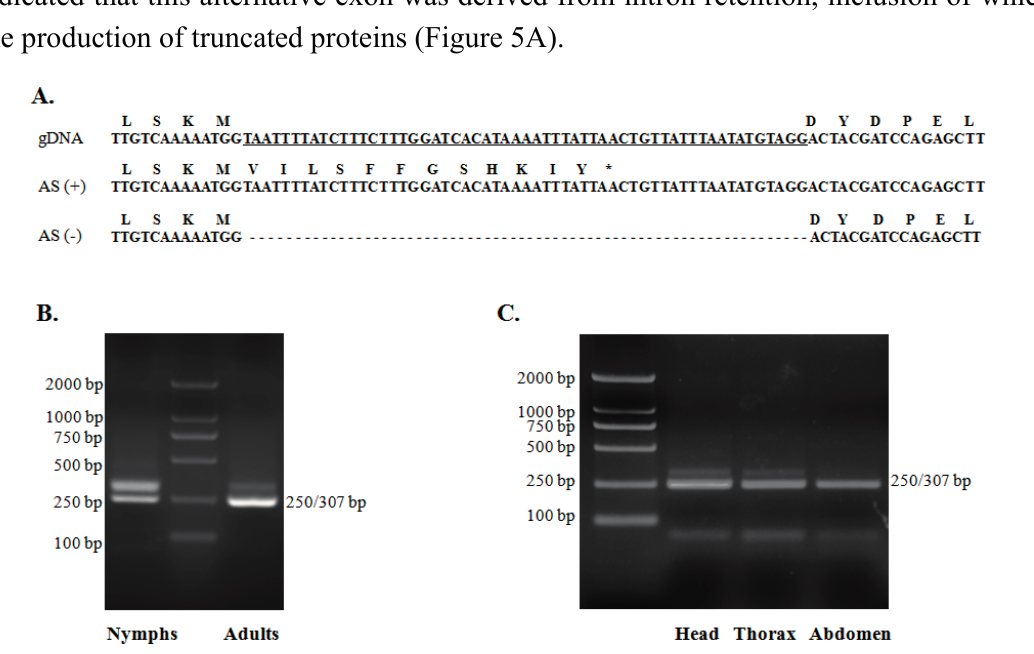
Figure 5. Alternative exon in TciRyR . ( A ) Nucleotide and inferred amino acid sequences of alternative exons in the TciRyR gene. Underlined sequence indicates the intron; ( B ) Semi-qRT-PCR detection of AS in nymphs and adults stages; ( C ) Semi-qRT-PCR detection of alternatively spliced (AS) in adult head, adult thorax, and adult abdomen. Different bands indicate the presence or absence of specific exons in the various PCR products. Semi-qRT-PCR products were separated on a 2% agarose